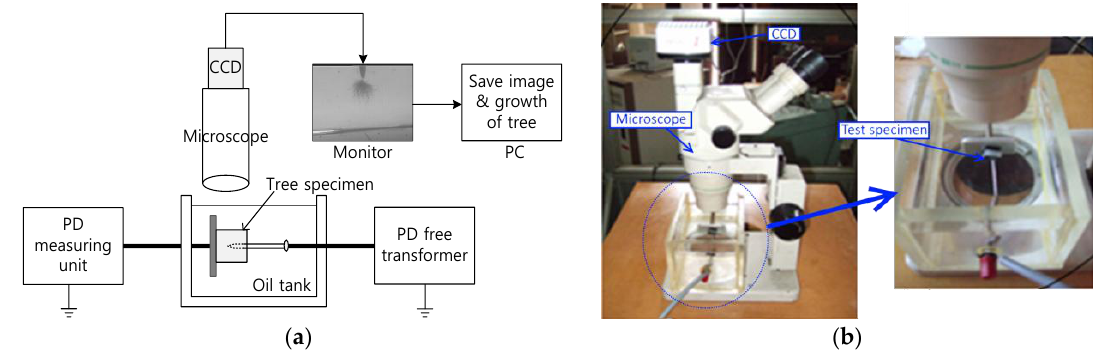
Figure 3. This is diagram of the tree image observation process and setup to see the tree propagation image: ( a ) Tree image observation process; ( b ) Microscope and Charge Coupled Device (CCD) with test specimen.